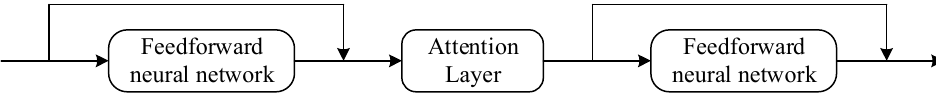
Figure 3. Structure diagram for each block.